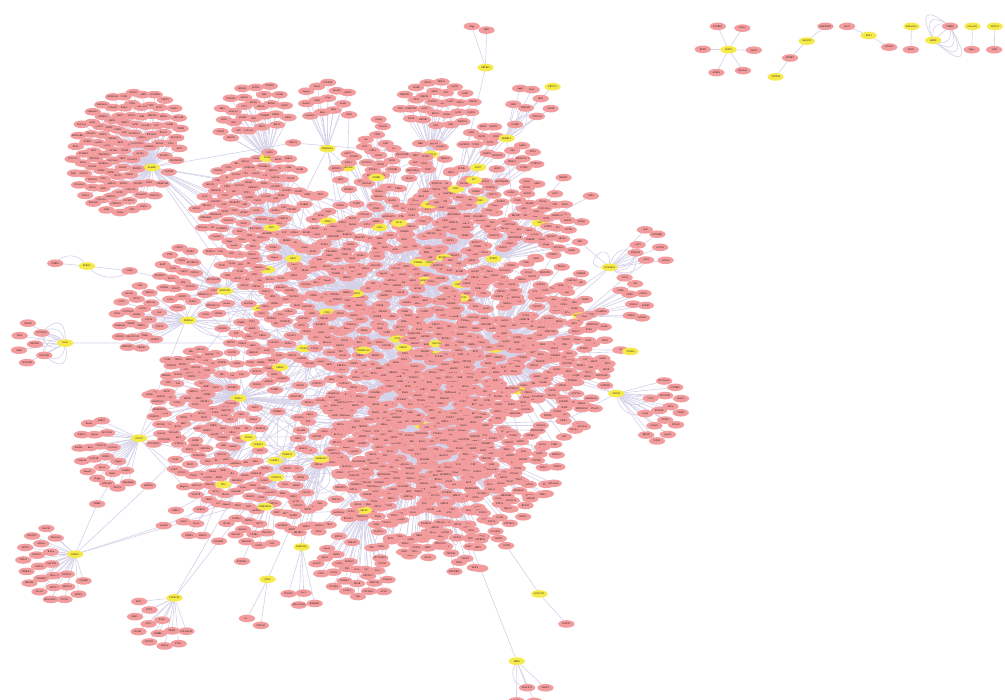
Figure 2: PPI of osteoporosis GWAS-associated genes (the pink nodes indicated those which had interactions with the osteoporosis GWAS- associated genes, and the yellow nodes indicated the osteoporosis GWAS-associated genes).